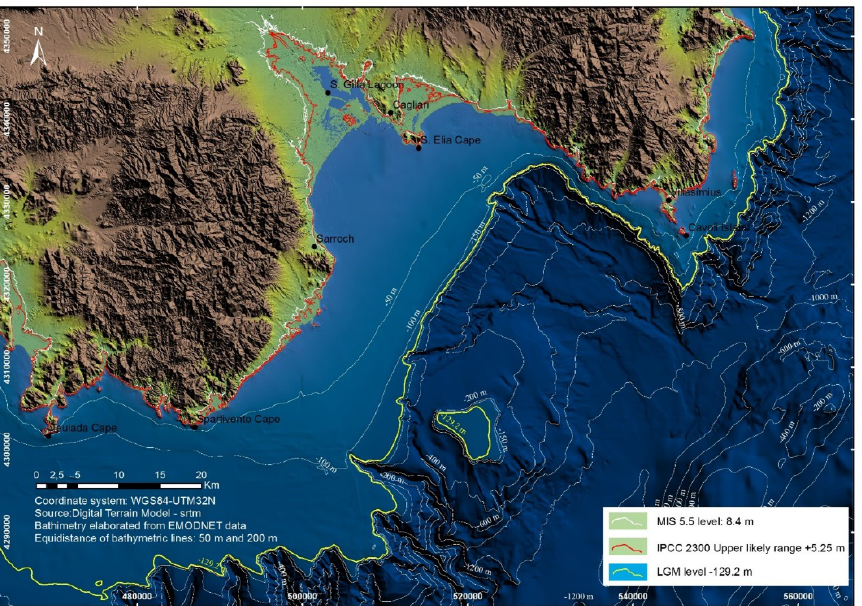
Figure 16. The Cagliari plane map showing the potential submersion area using IPCC AR5 RCP 8.5 for 2100 and 2300: the MIS 5.5 extension occurred 119 ka BP.